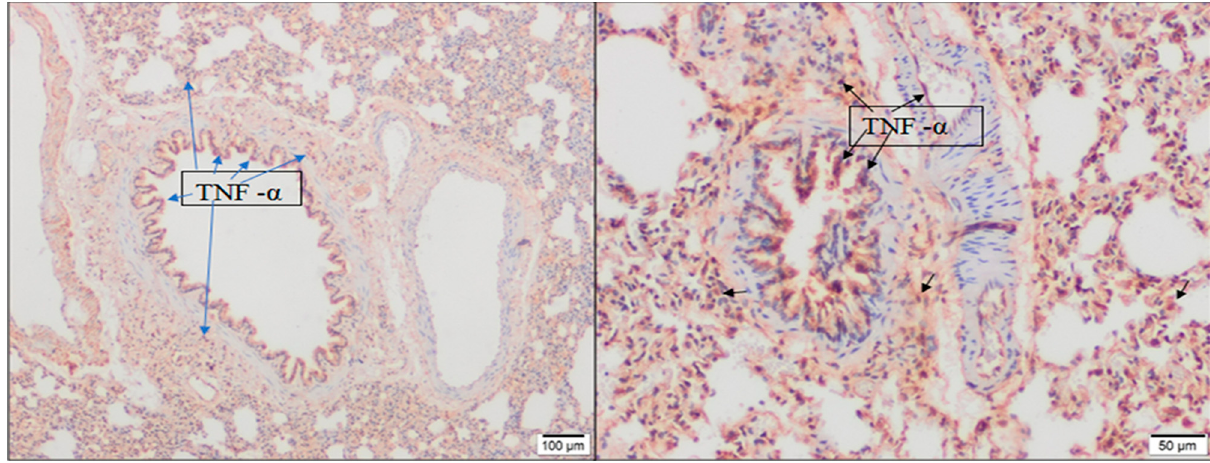
Figure 5. Intense TNF- α expression in alveoli, bronchial and bronchiolar epithelium, inflammatory cells (short black arrow) in lung tissue sections (10× and 20× magnification, respectively) in 15% NaOCl group.